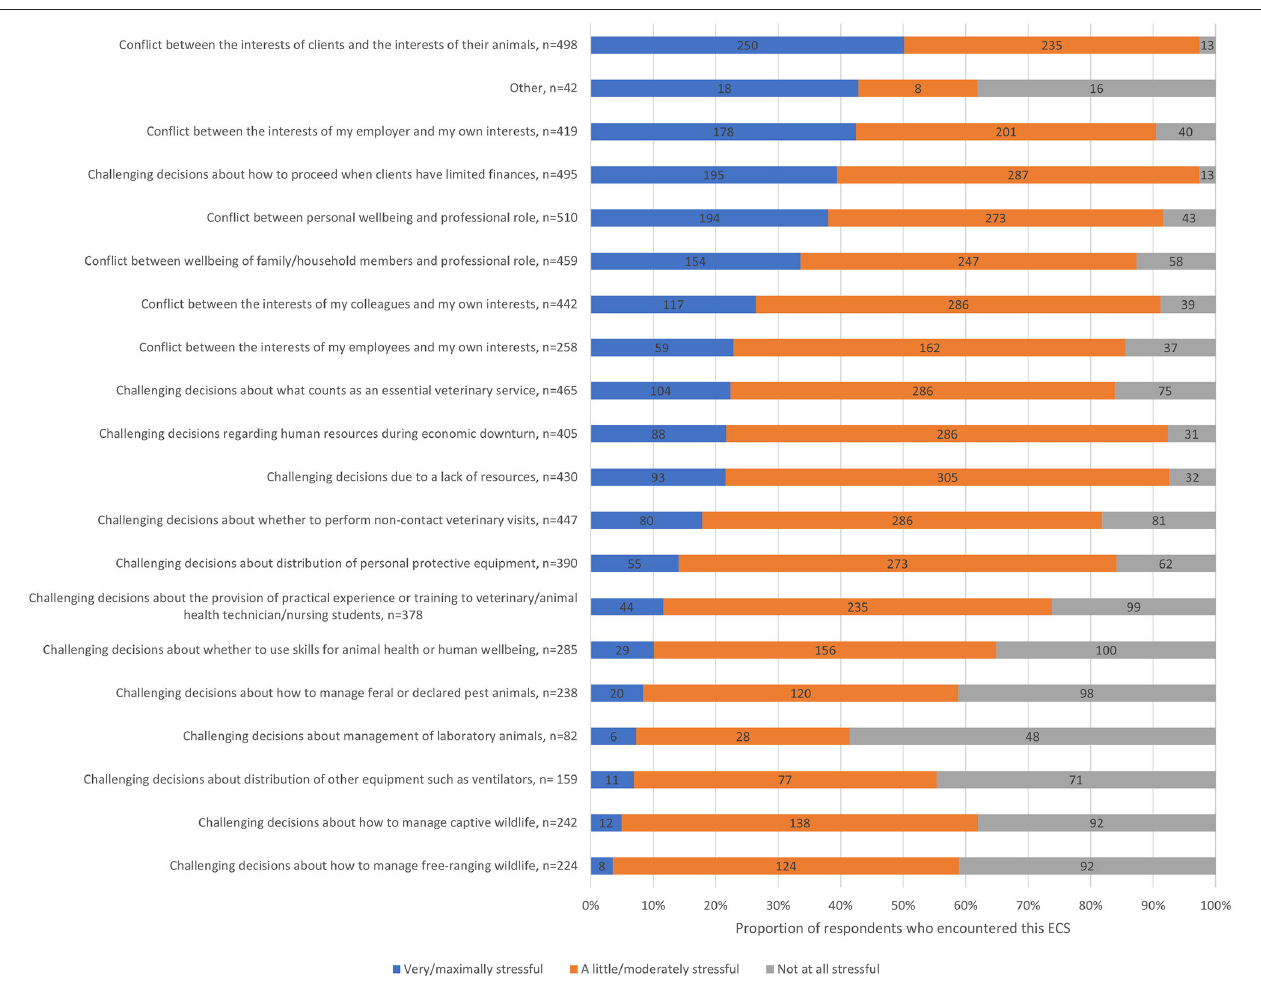
FIGURE 3 | Stacked bar chart for the most stressful ethically challenging situations encountered by veterinary team members since the advent of the COVID-19 pandemic, based on the responses of 540 veterinarians, animal health technicians and veterinary nurses, surveyed between May and July in 2020.